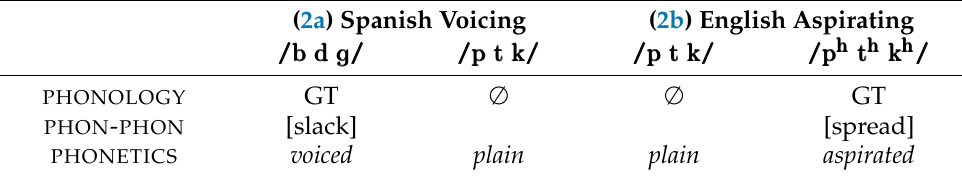
Table 1. Voicing and aspirating laryngeal representations and